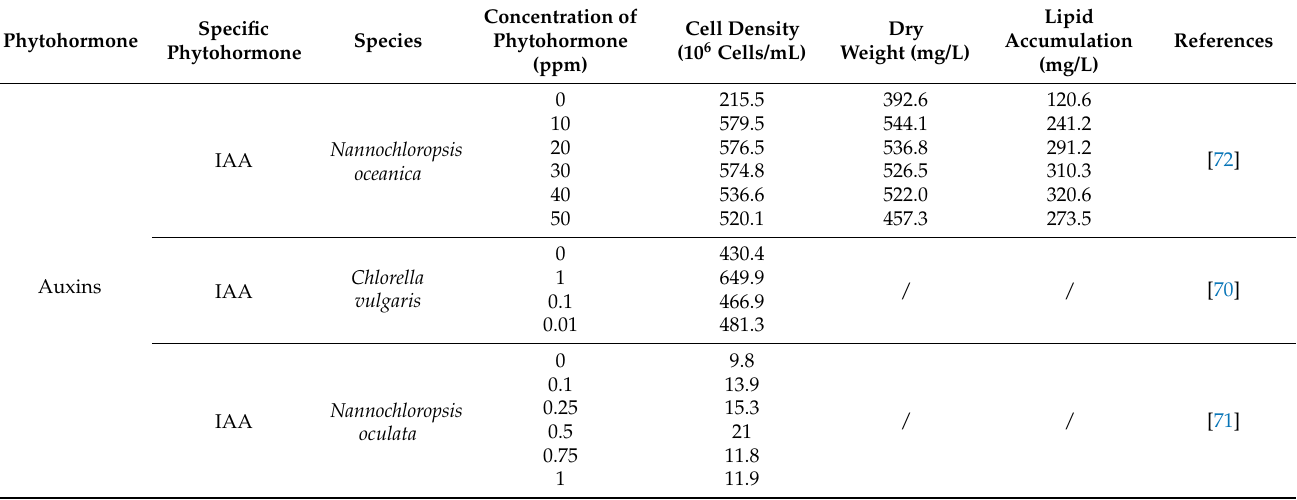
Table 1. Effect of phytohormones on the growth and lipid accumulation of microalgae.